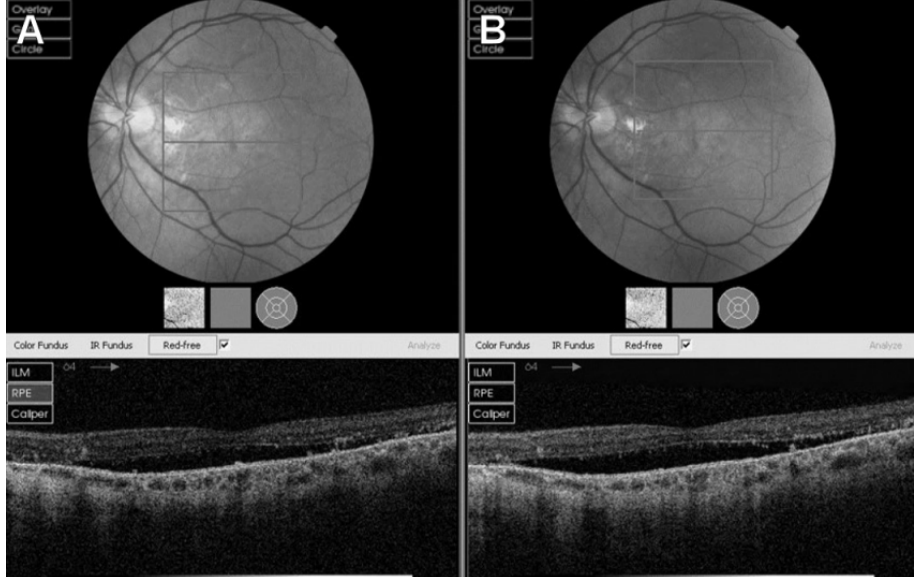
Figure 2: A) Left eye showing poor response post-PDT at 4 months. B) Left eye showing persistent neurosensory elevation post-PDT at 6